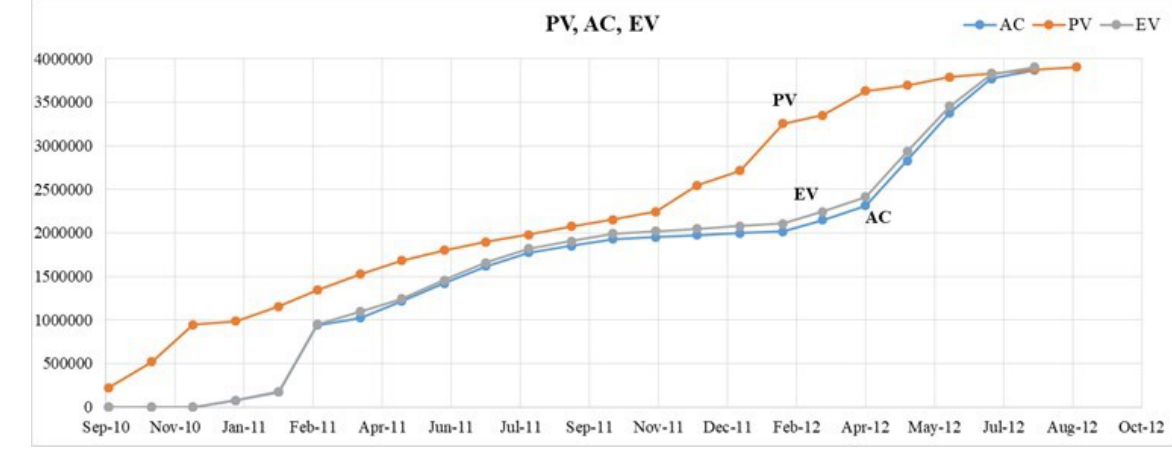
Figure 2: PV, AC, EV [authors’ data]